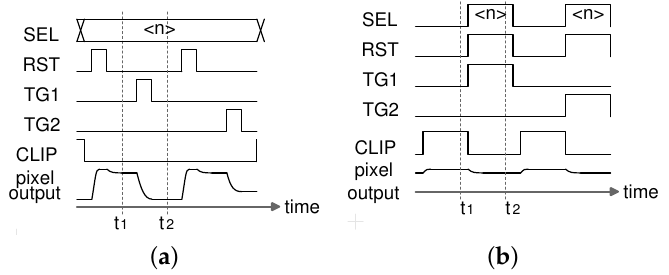
Figure 3. Timing diagrams of imaging mode and PUF mode. ( a ) Imaging mode. ( b ) PUF